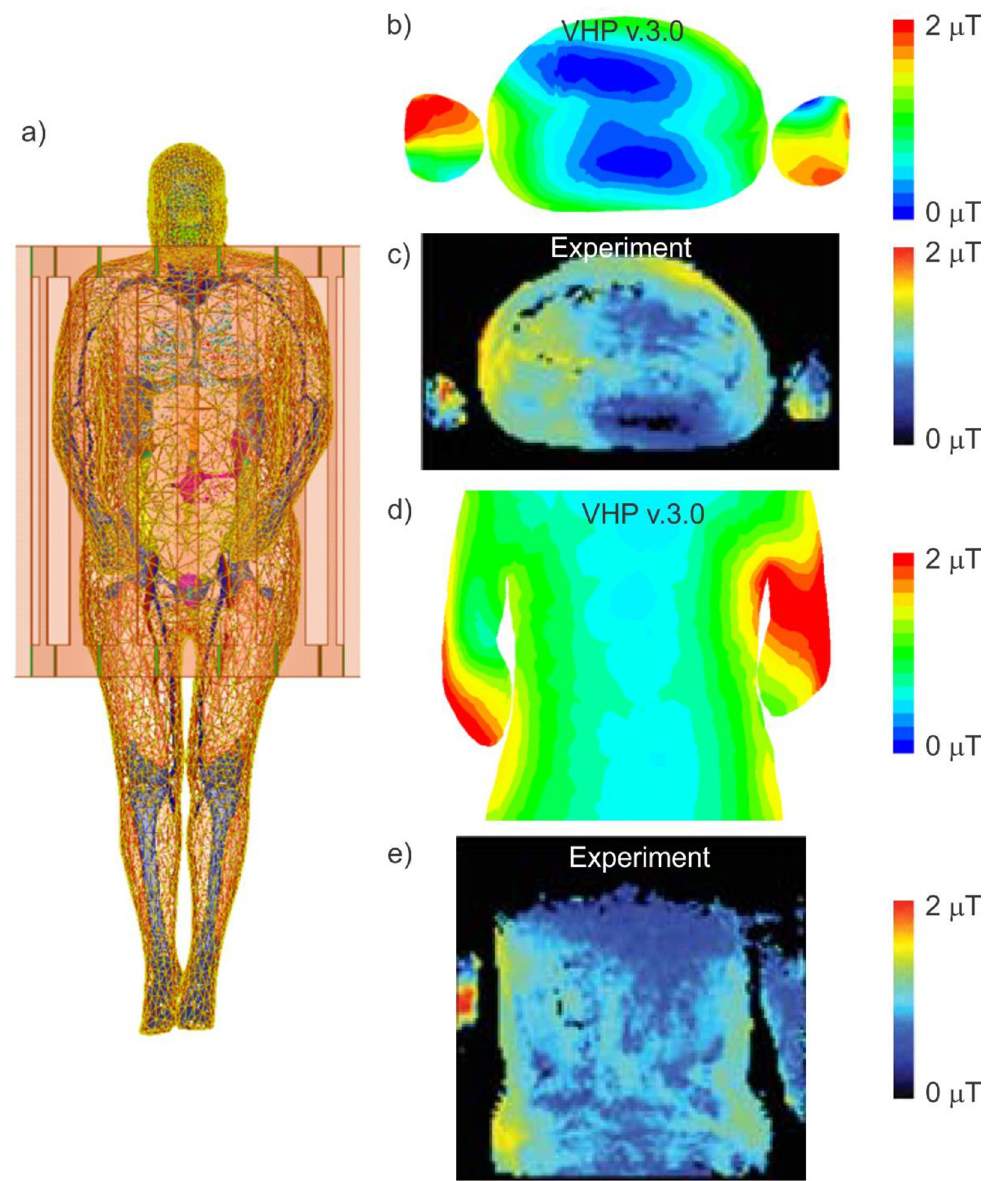
Fig 6. The VHP-Female computational phantom positioned with a 3T MRI birdcage coil at the abdominal landmark. a)–The model geometry is shown, providing a view of the phantom located in the coil. b)–The simulated B þ generated in the axial plane about the model mid-section. c)–The experimental B þ simulated B þ map generated in the coronal plane about the VHP Female model mid-section. e)–The measured B þ 1 generated in a coronal plane at the approximate middle of the model. These values are also reviewed in Table 2.